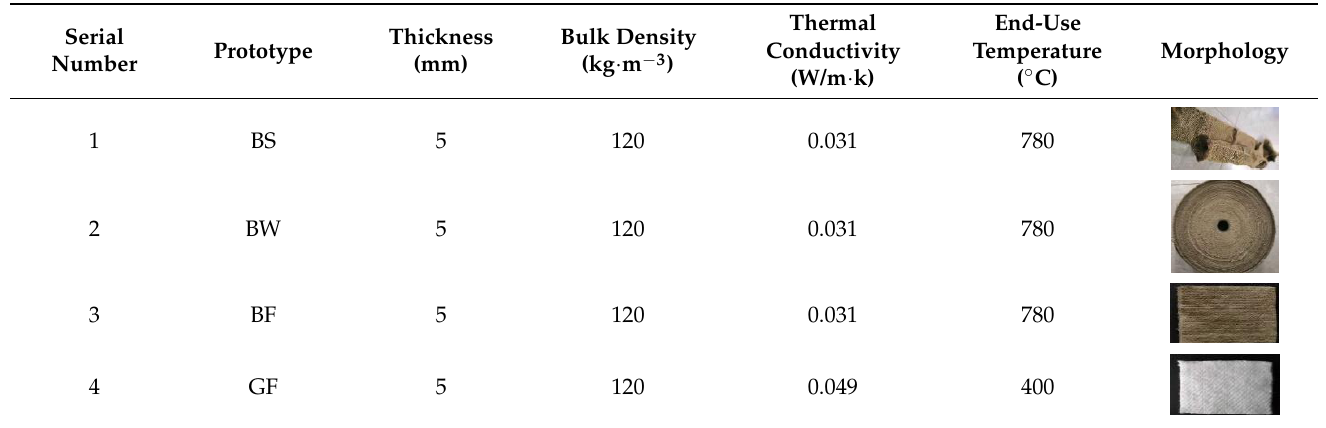
Table 1. Test sample.